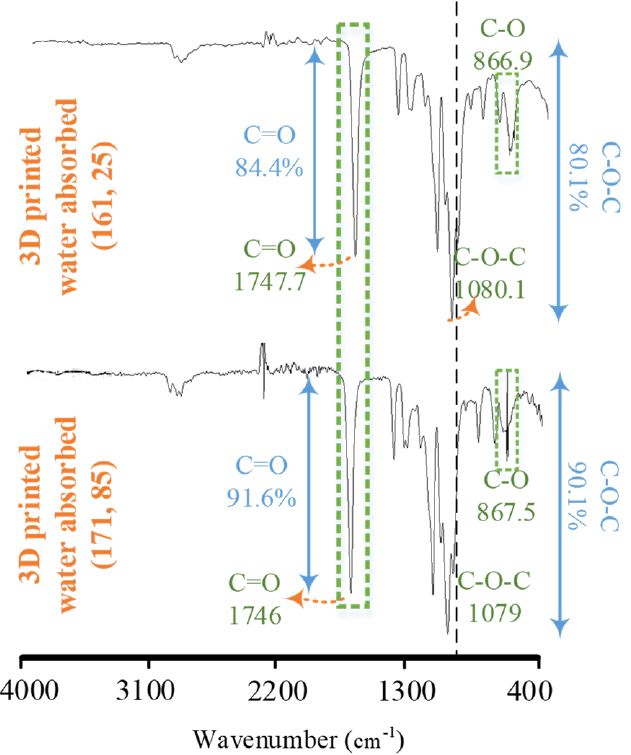
Figure 8. FTIR analysis for moisture degradation at the lowest and highest temperature combinations. The moisture treatment on the ternary blend is observed in Figure 9. The high- temperature combinations were detected with high enthalpy of cold crystallization ( ∆ H C ), melt crystallization ( ∆ H M ), and degradation ( ∆ H D ) as compared to low-temperature com- binations. The values at high-temperature combinations for ∆ H C , ∆ H M , and ∆ H D were 13.89, 19.39, and 637.3 J/g, as compared to 11.54, 18.22, and 522.7 J/g, respectively. Based on the literature, the high temperature can result in enhanced intermolecular reorientation of the chains to graft through MAH [13]. FTIR analysis also detected the depletion of amorphous regions to result in a strange increase of C-O-C bonds, which causes ease of mobility of C-O-C bonds to reorient into crystalline regions. The increase of crystalline enthalpies in DSC at high temperature, that resulted after degradation of the amorphous regions detected in FTIR, proved to be sufficient to increase the tensile strength in ANOVA main effects plots (Figure